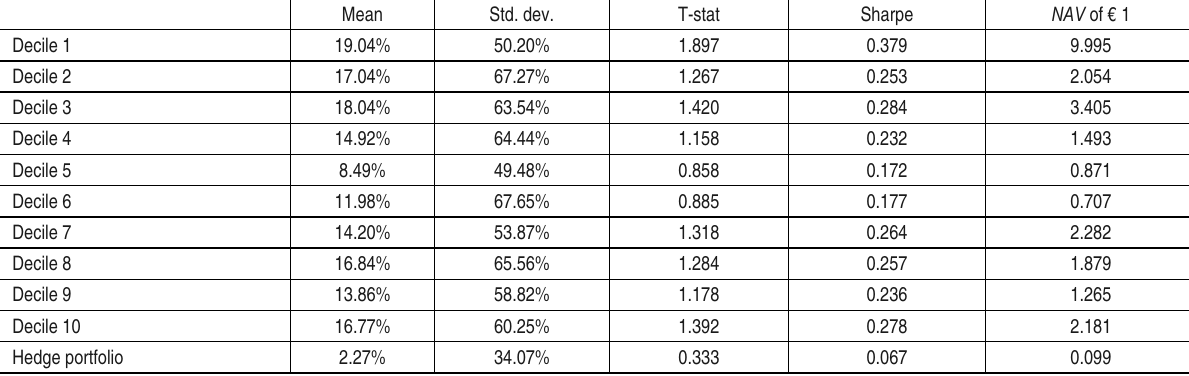
Hedge portfolio